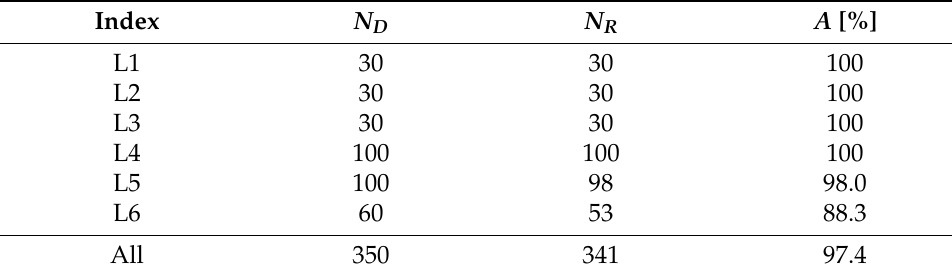
Table 5. Ground communication experiment results.